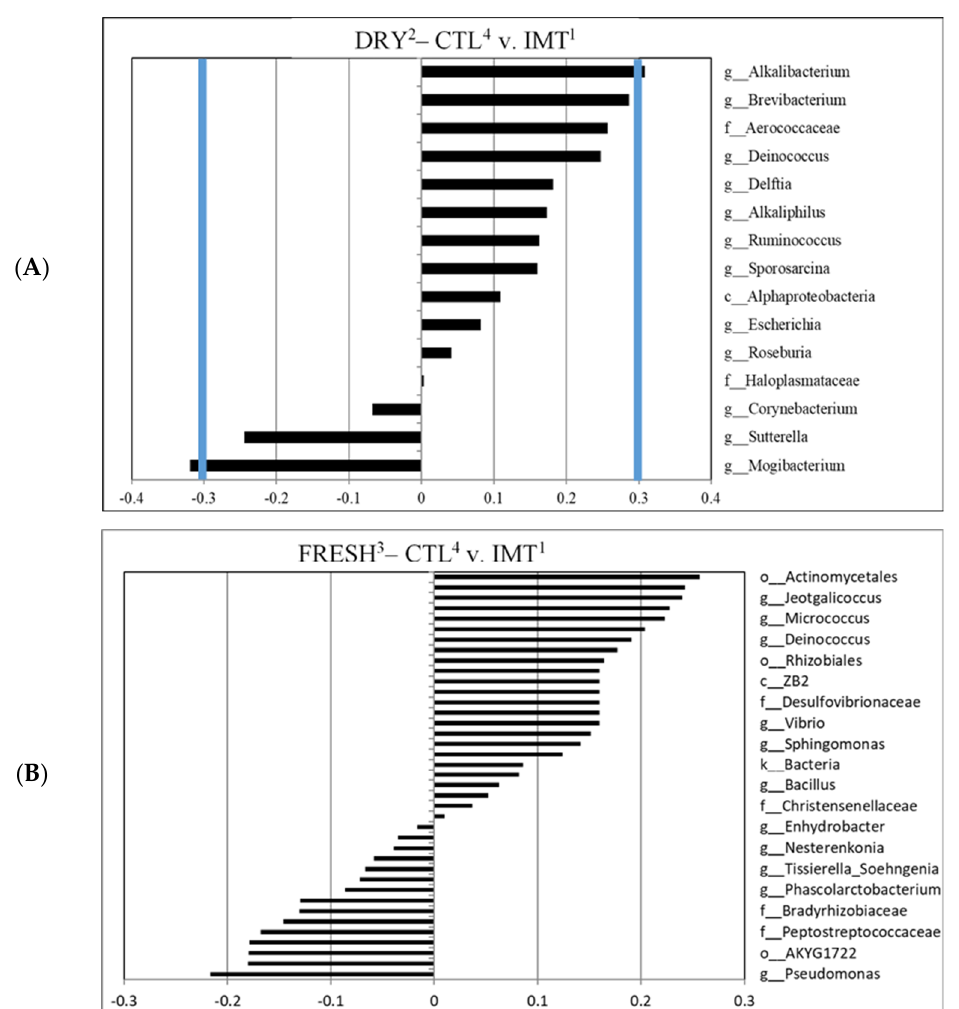
Figure 5. Canonical structure coefficients comparing sampling microbiota for cows receiving intramammary antimicrobial treatment (IMT) at dry − off and cows not receiving intramammary antimicrobial treatment (CTL) at dry-off. ( A ) Correlation between microbial taxa and the discriminant function for DRY, comparing CTL versus IMT samples. ( B ) Correlation between microbial taxa and the discriminant function for FRESH, comparing CTL versus IMT samples. Bacterial taxa with canonical structure coefficients ≤− 0.3 or ≥ 0.3 (blue lines) are considered important when distinguishing between CTL and IMT samples. 1 IMT: treatment group representing cows receiving intramammary antimicrobial drug treatment at dry-off. 2 DRY: samples collected at the time of dry-off. 3 FRESH: samples collected from post-partum cows between 4 and 11 days in milk. 4 CTL: control group representing cows not receiving intramammary antimicrobial drug treatment at dry-off.